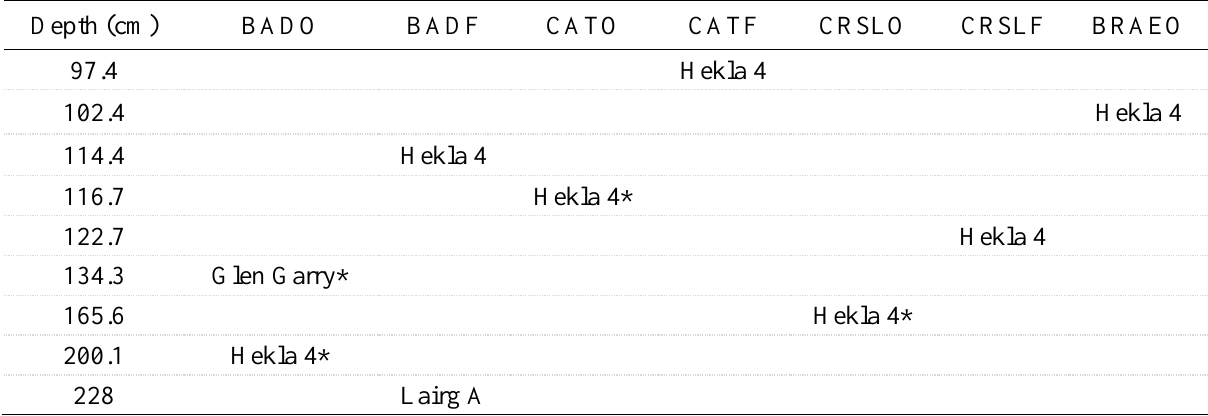
Table 2. Identified tephra layers which could be linked to previously-described tephra based on their major element geochemistry. Reference data for identification were taken from Tephrabase (Newton et al. 2007). The tephra layers found are generally referred to by the site code and depth; for example, BADO 200 indicates the tephra located at 200 cm depth in core BADO. * indicates tephra for which geochemical data are available in Ratcliffe et al . (2018).